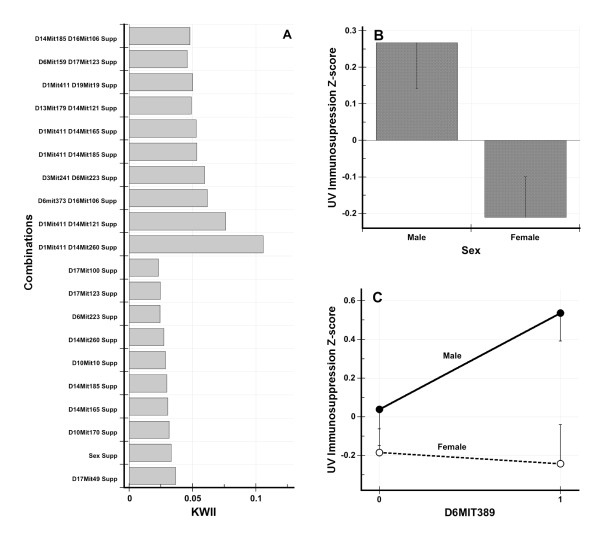
The KWII spectrum for the UV-induced immunosuppression data set is summarized in Figure 7A. The combinations are shown on the y-axis. The UV-induced immunosuppression denoted by the variable Supp on the y-axis. Figure 7B shows the UV-induced immunosuppression Z-score in males and females whereas Figure 7C shows the UV-induced immunosuppression Z-scores for the two genotypes of D6MIT89 in males and females. The error bars represent standard error of the mean.